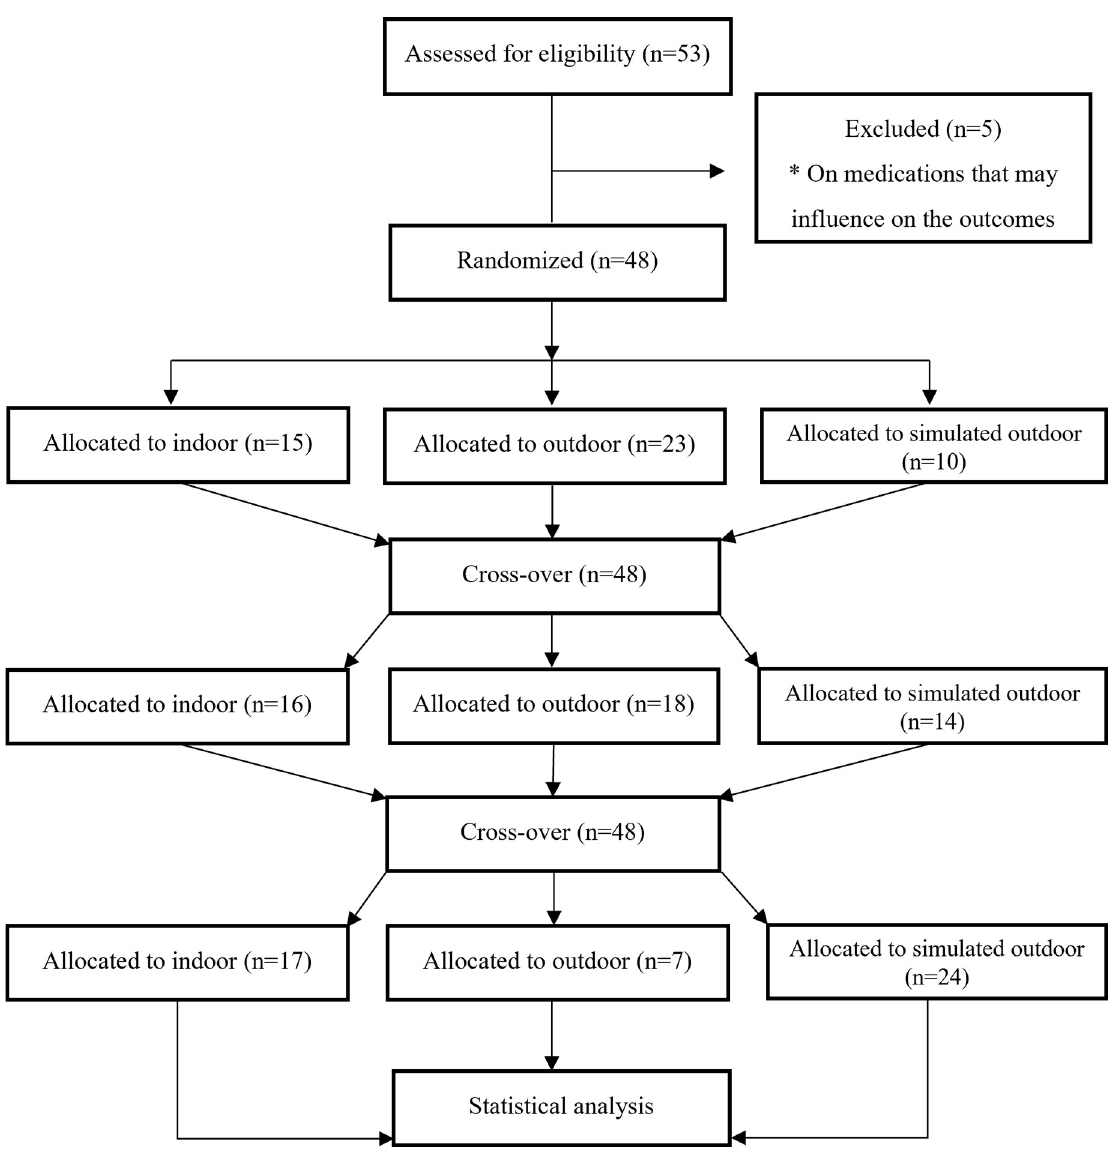
Fig 1. Flowchart showing the flow of participants through the